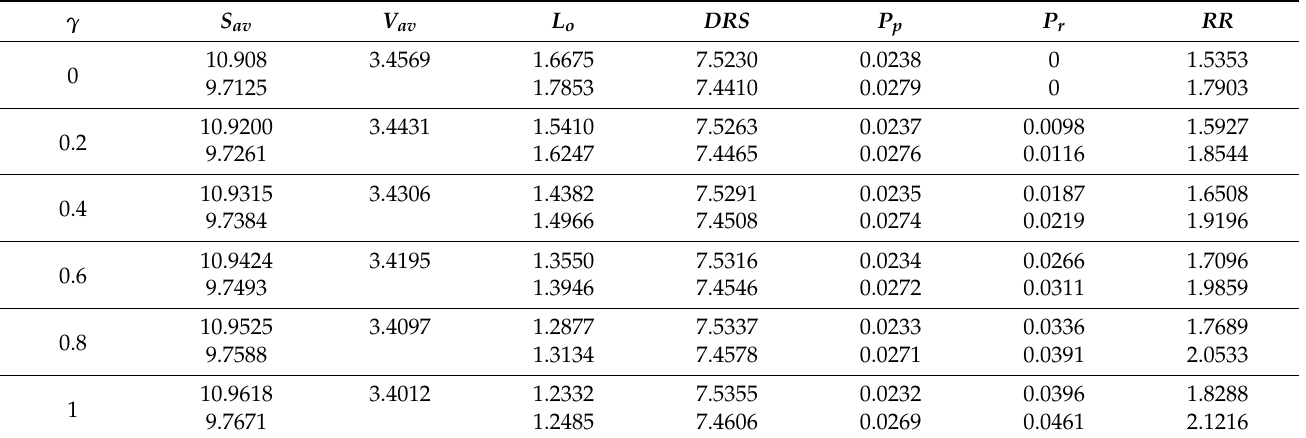
Table 7. Dependence of the performance measures on parameter γ ; λ = 20, η = 15, κ = 8, ν = 10, α = 0.4, and β =